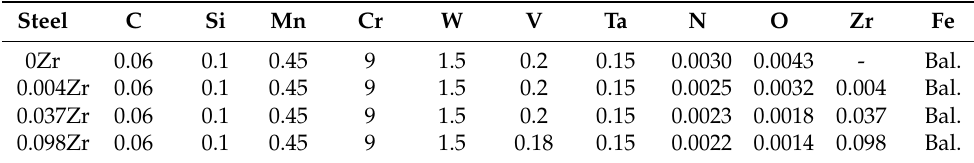
Table 1. Chemical compositions of experimental steels